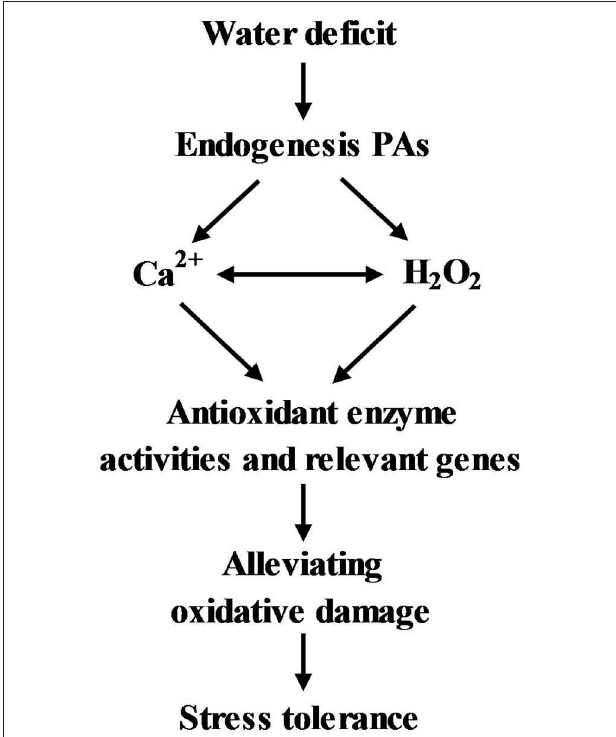
FIGURE 15 | A model for the polyamine (PA) regulation of Ca 2 + and H 2 O 2 signaling in control of antioxidant defense involved in tolerance to water stress in white